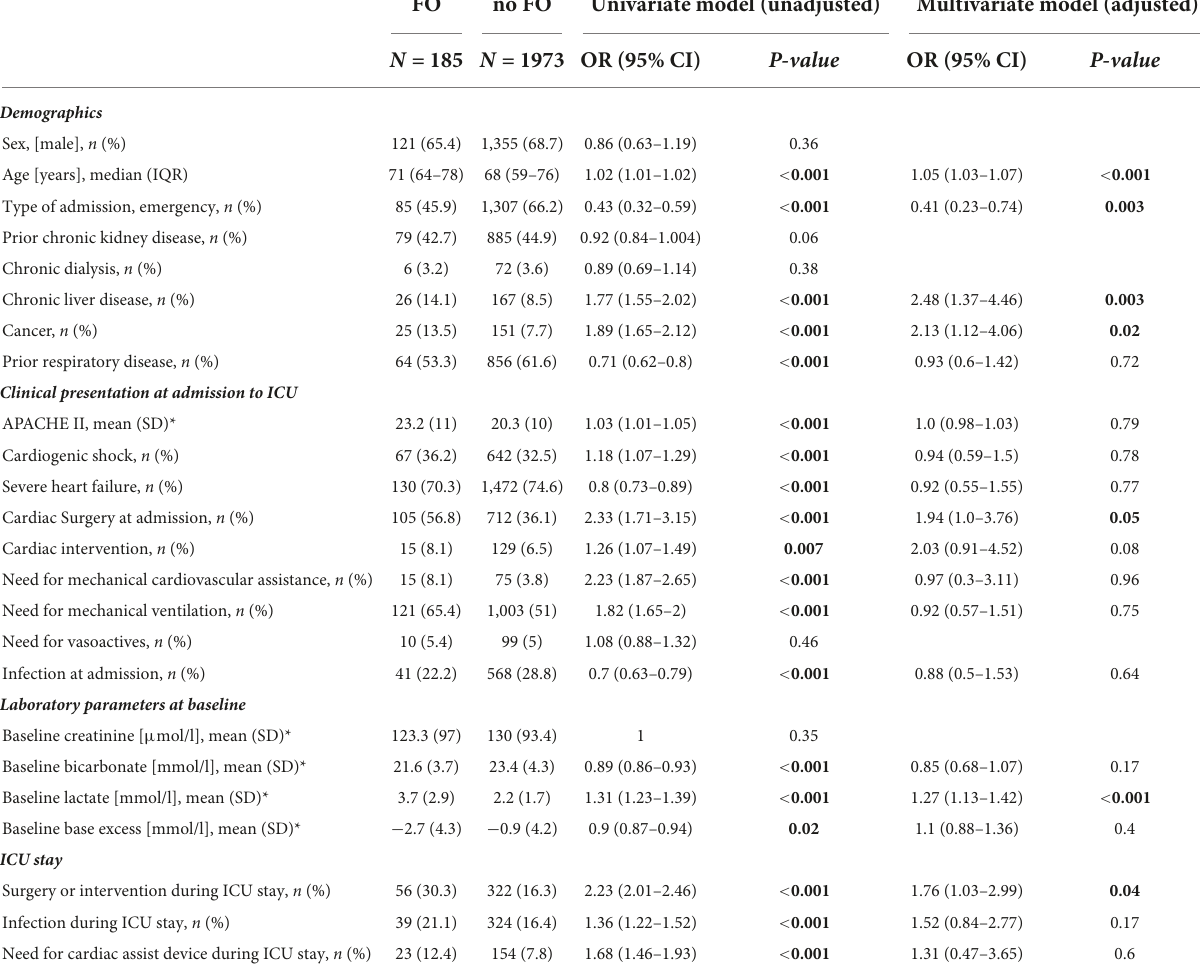
TABLE 2 Univariate and multivariate logistic regression analysis on risk factors for fluid overload at discharge. FO no FO Univariate model (unadjusted) Multivariate model (adjusted) N = 185 N = 1973 OR (95% CI) P-value OR (95%